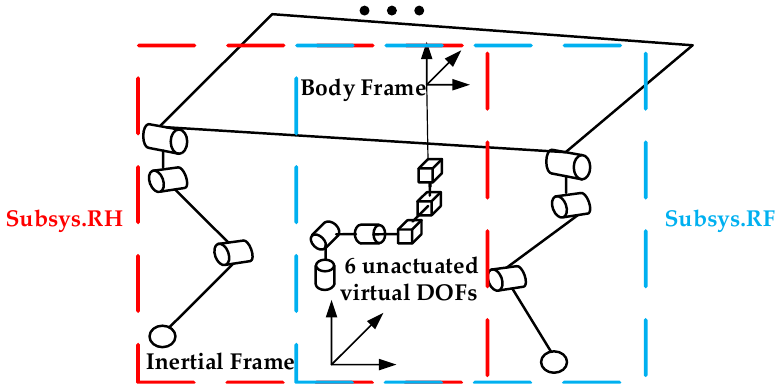
Figure 2. Segmentation of the floating base